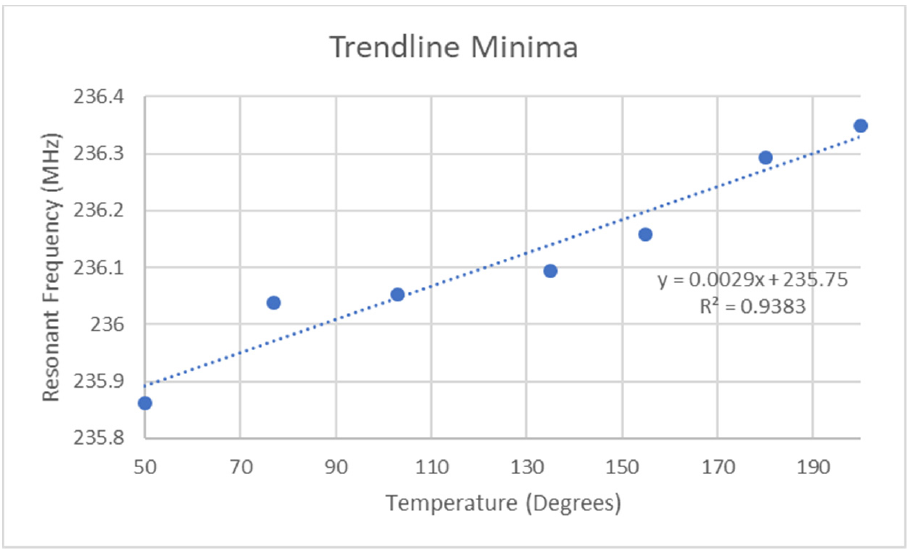
Figure 9. Best Temperature response from sensor.